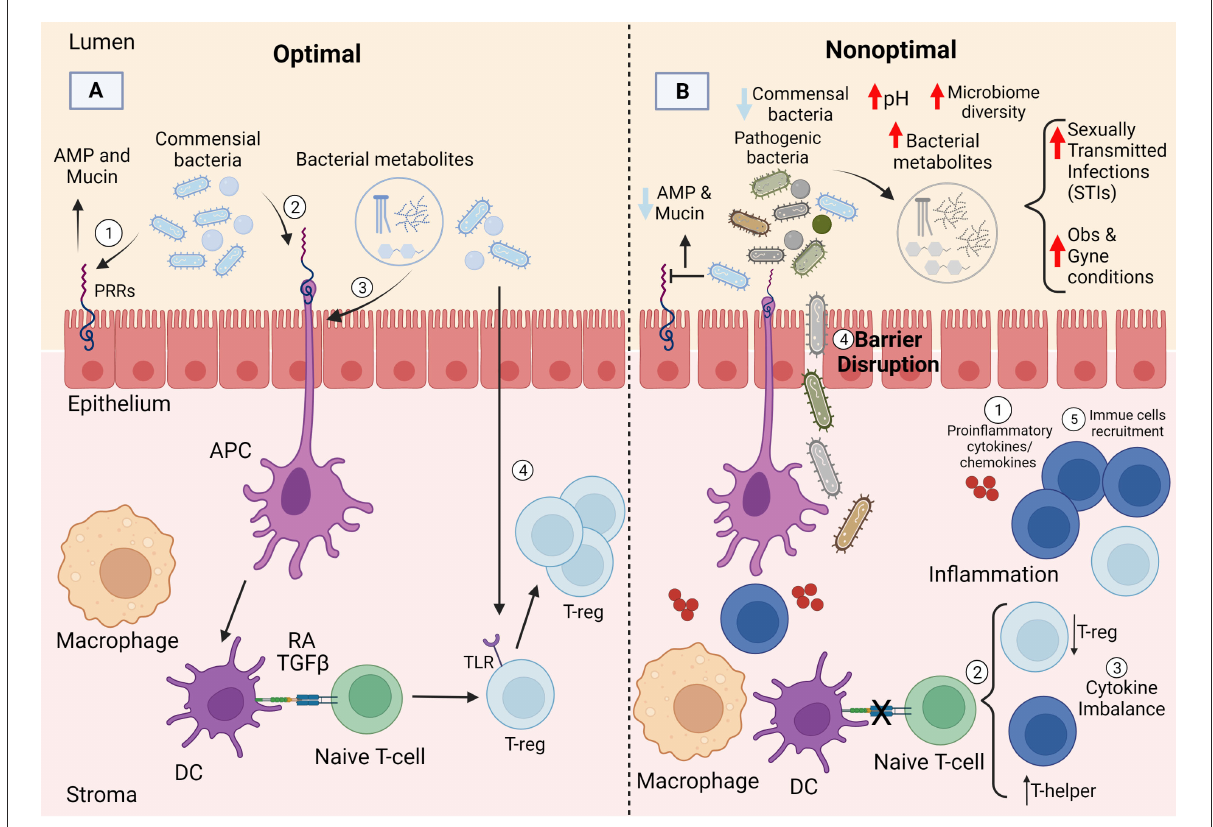
FIGURE2 Potential mechanism of immune homeostasis with the female reproductive tract microbiotas. (A) Commensal bacteria likely maintain homeostasis by interacting with the epithelial cells via pattern recognition receptors (PRRs) and promoting induction of T-reg cells through different pathways: (1) commensal bacteria play an important role in preserving the epithelial barrier through antimicrobial peptide (AMP) and mucin production, (2&3) commensal bacteria or bacterial metabolites can induce antigen presenting cells, such as dendritic cells (DCs) that favor T-reg selection through production of retinoic acid (RA) and TGF- β , (4) commensals can also facilitate tolerance through signaling and triggering toll-like receptors (TLRs). (B) The loss of commensal bacteria can lead to increased microbial diversity and changes in immune and epithelial homeostasis likely through multiple mechanisms including: (1) production of pro-inflammatory cytokines and chemokines, (2) decrease in T-reg frequency and increase in T-helper cells; ultimately resulting in (3,4&5) cytokine imbalance, barrier disruption, and immune cell recruitment. Created with